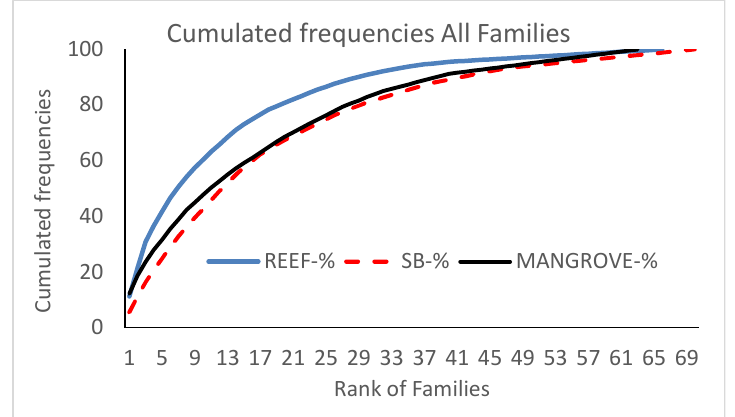
Figure 4. Cumulated frequencies of species per families according to habitat. Families were ranked according to their number of species, from the most to the least speciose. SB: soft-bottoms. The profiles of species frequencies amongst families were different for the three hab- itats (Supplementary Materials Table S5; Figure 4). On reefs, a large proportion of species were concentrated in few families (Figure 4), whereas the profiles for mangroves and soft- bottoms were similar, with a lower contribution of the most speciose families. The pro- portion of families represented by a single species was the highest on reefs (61% of fami- lies) followed by soft-bottoms (57%) and mangroves (49%). The species exclusive to each habitat had a specific distribution across families (Sup- plementary Materials Table S5). Four families (Blenniidae, Gobiidae, Apogonidae, and Syngnathidae) had species composition with more than 50% exclusive species in each hab- itat. In other words, it is possible to determine the habitat of each assemblage with only these four families alone. Other families had specifically high proportion of exclusive spe- cies in each habitat (Supplementary Materials Table S5), in particular: Labridae, Pomacen- tridae, Chaetodontidae, Scaridae, Muraenidae, Holocentridae, and Acanthuridae on reefs; Clupeidae and Sphyraenidae on soft-bottoms; Mugilidae and Eleotridae in mangroves. 3.2. Diet and Trophic Level A comparison of the trophic level spectra across habitats (Figure 5) indicates a high similarity. However, two peaks exist for reef fish, one at trophic level 2.0 and another at 2.8, which respectively correspond to herbivores and mixed diets of plankton and algae, whereas one peak exists for both mangrove and soft-bottoms at trophic level 4.4, which corresponds to piscivores (Supplementary Materials Table S6). The most important trophic group (TL 3.1 to 3.8; Figure 5; Supplementary Materials Table S6) in all habitats was carnivores, with 56.4% for coral reef species, 51.5% for soft-bottom, and 54.2% for mangroves. Within this group, there were differences across habitats for the subgroups. Thus, reef fish were characterized by sessile invertebrate feeders and invertebrate/detritus feeders (class m2d), whereas soft-bottom fish had higher frequencies of micro-inverte- brate feeders (class m1) and mangroves had higher frequencies of macroinvertebrates feeders, with a secondary contribution of plankton in their diet (class m2-z). The highest trophic levels (adding nekton feeding species: n, n-m1, n-z) represented a larger propor- tion of the species on soft-bottoms (22.6%) and mangroves (22.7%) compared to coral reefs (12.5%) (SB-M > R, p < 0.01). Plankton feeders represented a larger proportion of species on soft-bottoms (22.3%) than reefs (16.5%) or mangroves (14.1%). Detritus feeders were mainly found in mangroves, but accounted for only 3.8% of the species (Supplementary Materials Figure S1C). Herbivores represented an important group only for reefs (14.2% of species, versus 4.7% for soft-bottoms, and 7.3% for mangroves).